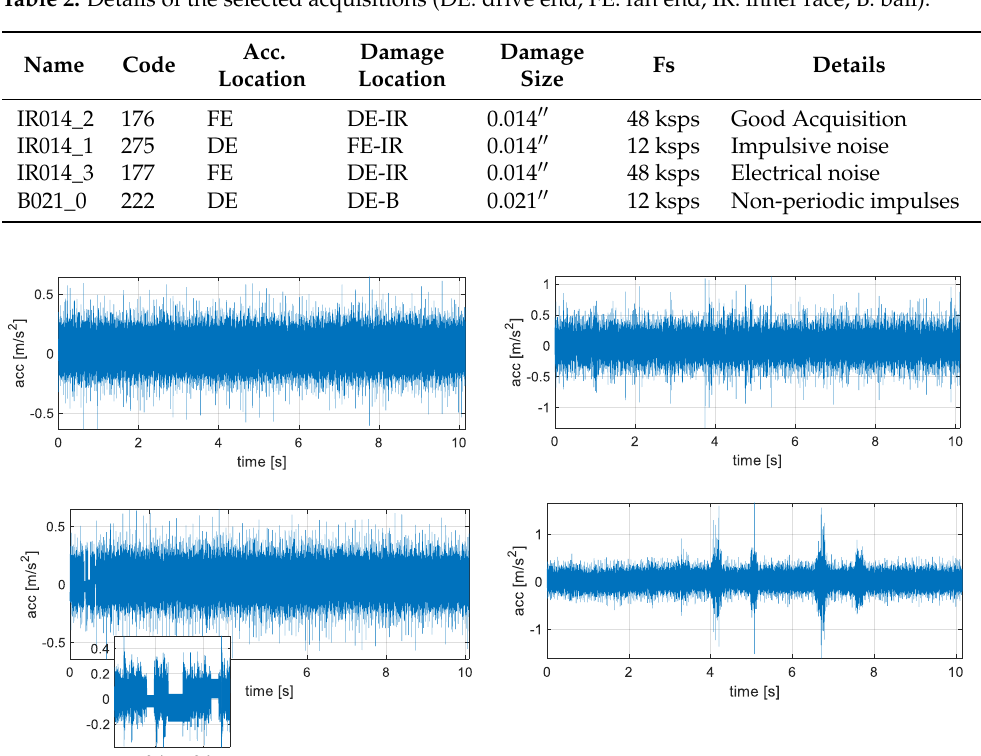
Table 2. Details of the selected acquisitions (DE: drive end, FE: fan end, IR: inner race, B: ball).